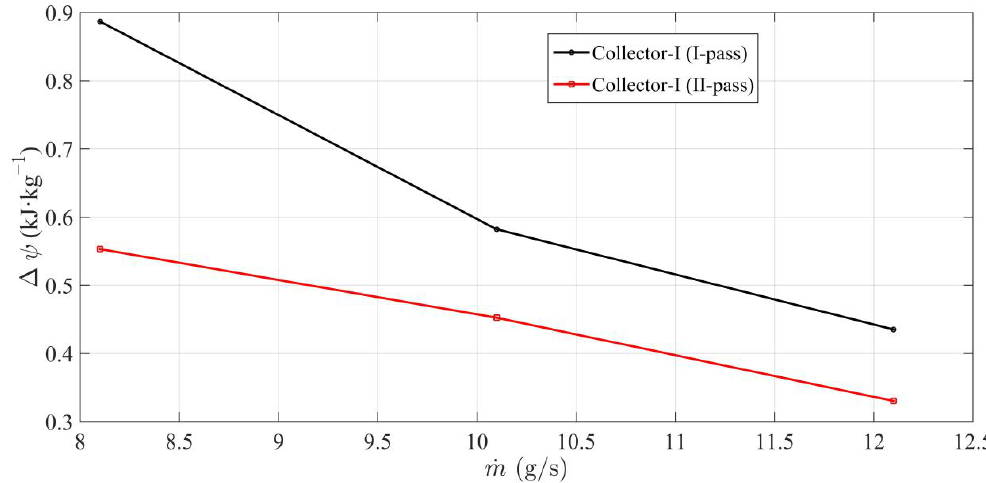
Figure 6. The change in exergy function (∆ ψ ) of the system with the air flow rate ( 𝑚̇ ).